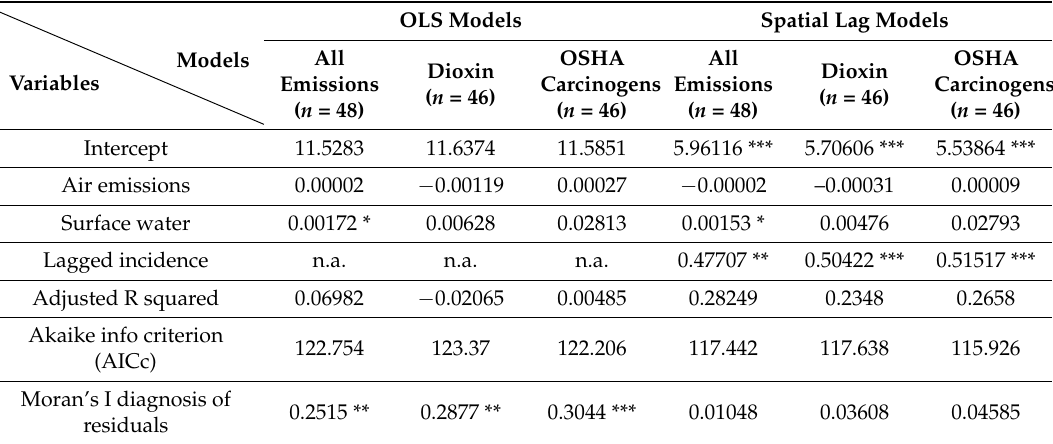
Table 1. Results of state-level regression